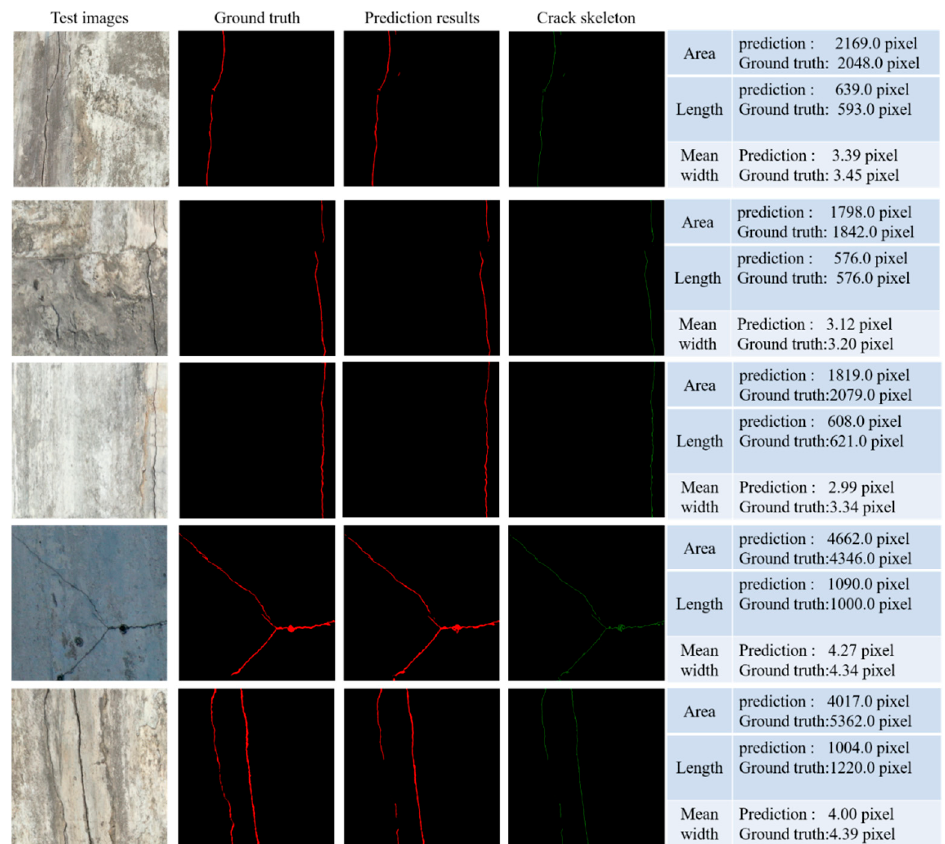
Figure 12. Schematic diagram of the size of the crack calculation process.